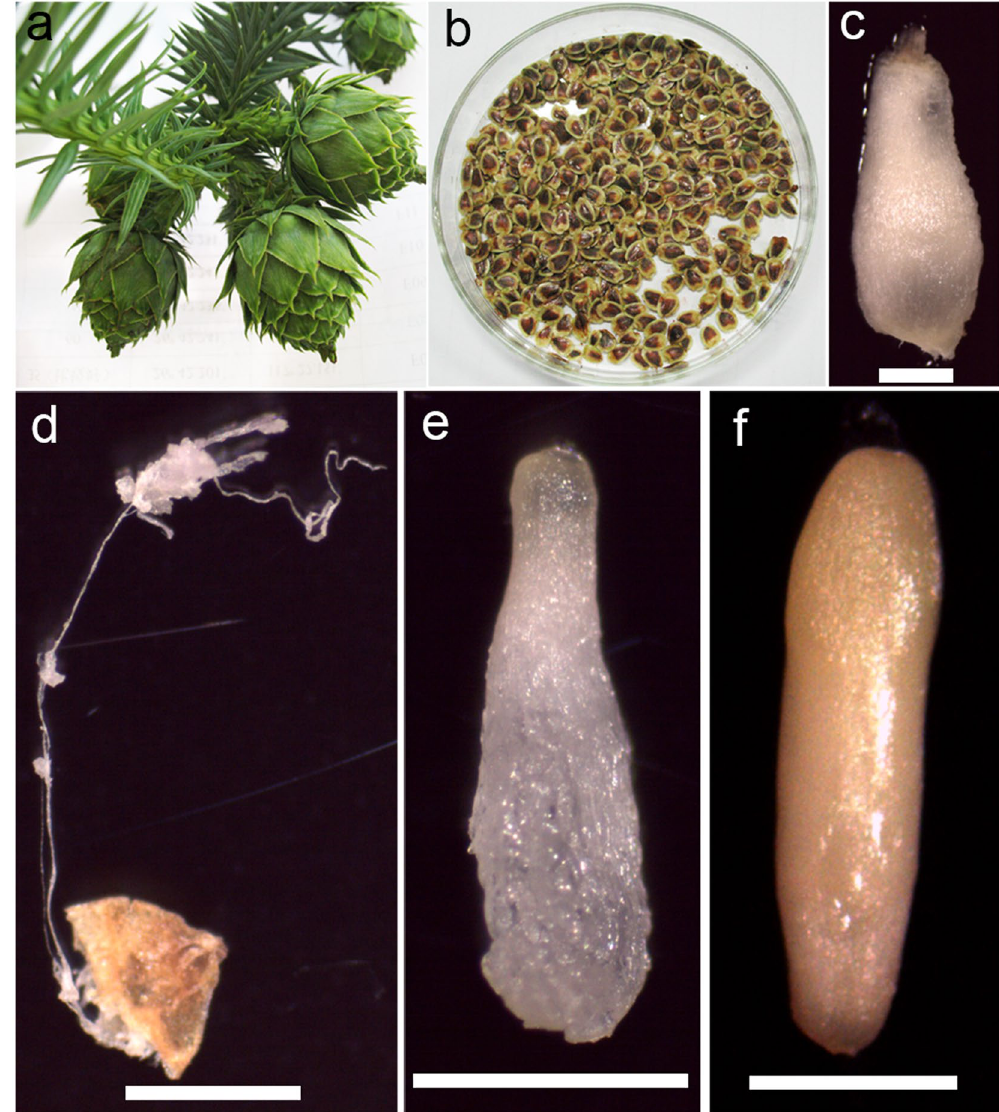
Figure 1. Developmental stages of Cunninghamia lanceolate zygotic embryos collected on different dates and from different seed orchards. ( a ) Green female cones. ( b ) Immature seeds. ( c ) Megagametophyte. ( d ) Embryos at the cleavage polyembryony stage. ( e ) Embryos at the dominant embryo stage. ( f ) Embryos at the precotyledon stage. Bars 1 mm.